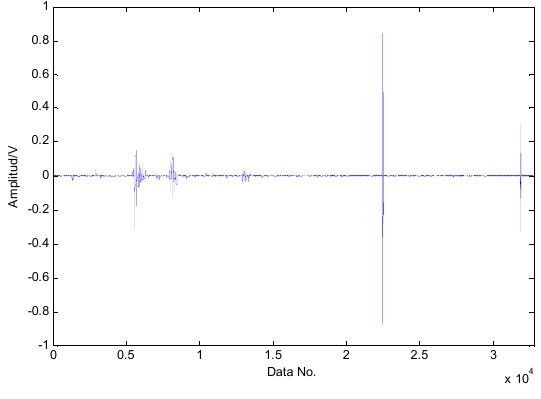
Figure 21. Kurtogram of the signals as shown in Figure 16.